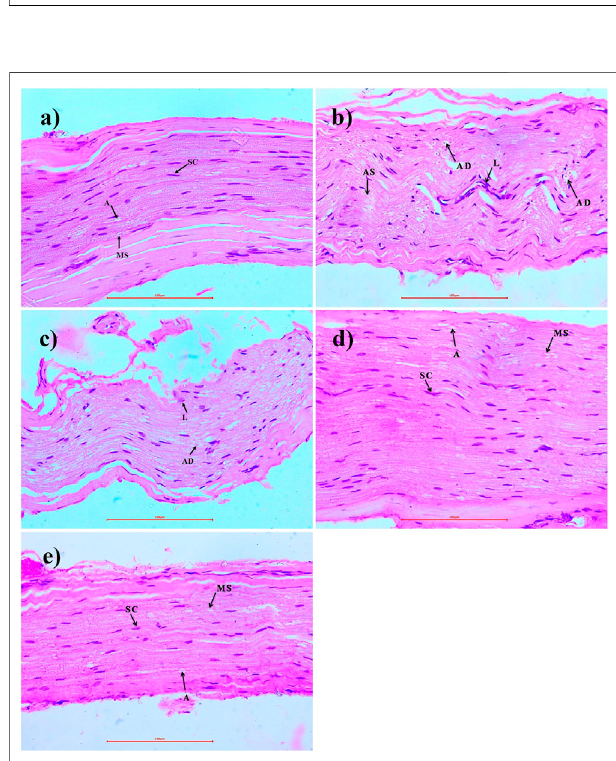
FIGURE 5 | Effect of Triphala churna on sciatic nerve tissue - H.E. staining (400X). (A) Normal control: Sciatic Nerve showing normal histology, myelin sheath (MS), Schwann cells (SC), axon (A). (B) Diabetic control: showing degeneration of axon (AD), lymphocytic in fi ltration (L), axonal swelling (AS). (C) Diabetic + Triphala (250 mg/kg): showing degeneration of axon (AD), lymphocytic in fi ltration (L). (D) Diabetic + Triphala (500 mg/kg): showing normal histology, myelin sheath (MS), Schwann cells (SC), axon (A). (E) Diabetic + Triphala (1,000 mg/kg): showing normal histology, myelin sheath (MS), Schwann cells (SC), axon